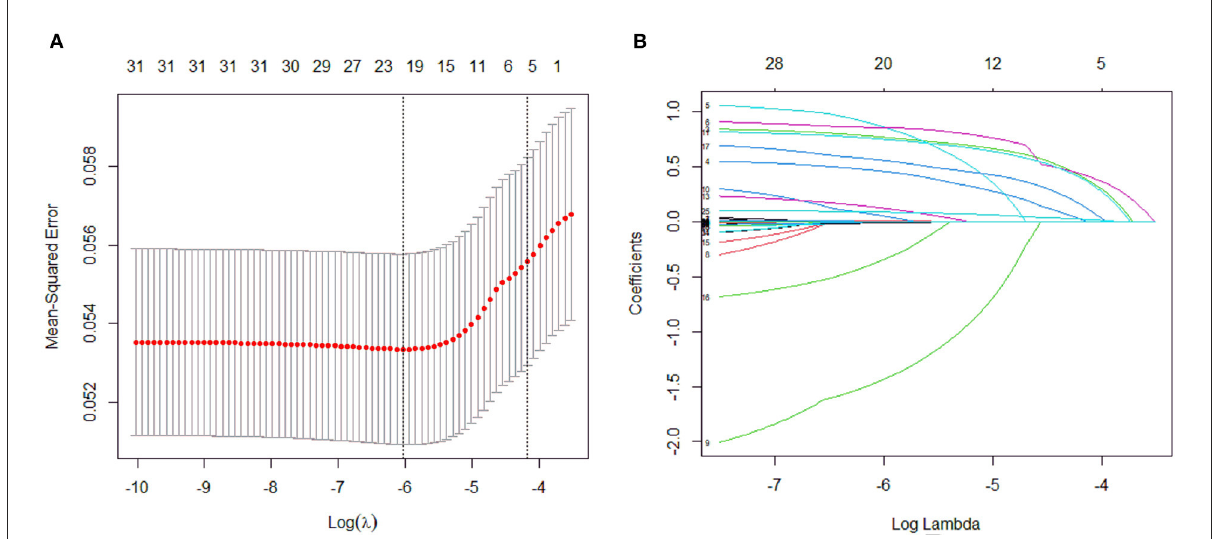
FIGURE1 Variables selection and coefficient estimation by LASSO regression analysis. (A) Ten-fold cross-validation was performed to select the optimal λ with the minimized binomial deviance. Dotted vertical lines were drawn at the optimal values by using the minimum criteria and the 1 SE of the minimum criteria. (B) LASSO coefficient profiles of the 31 variables.